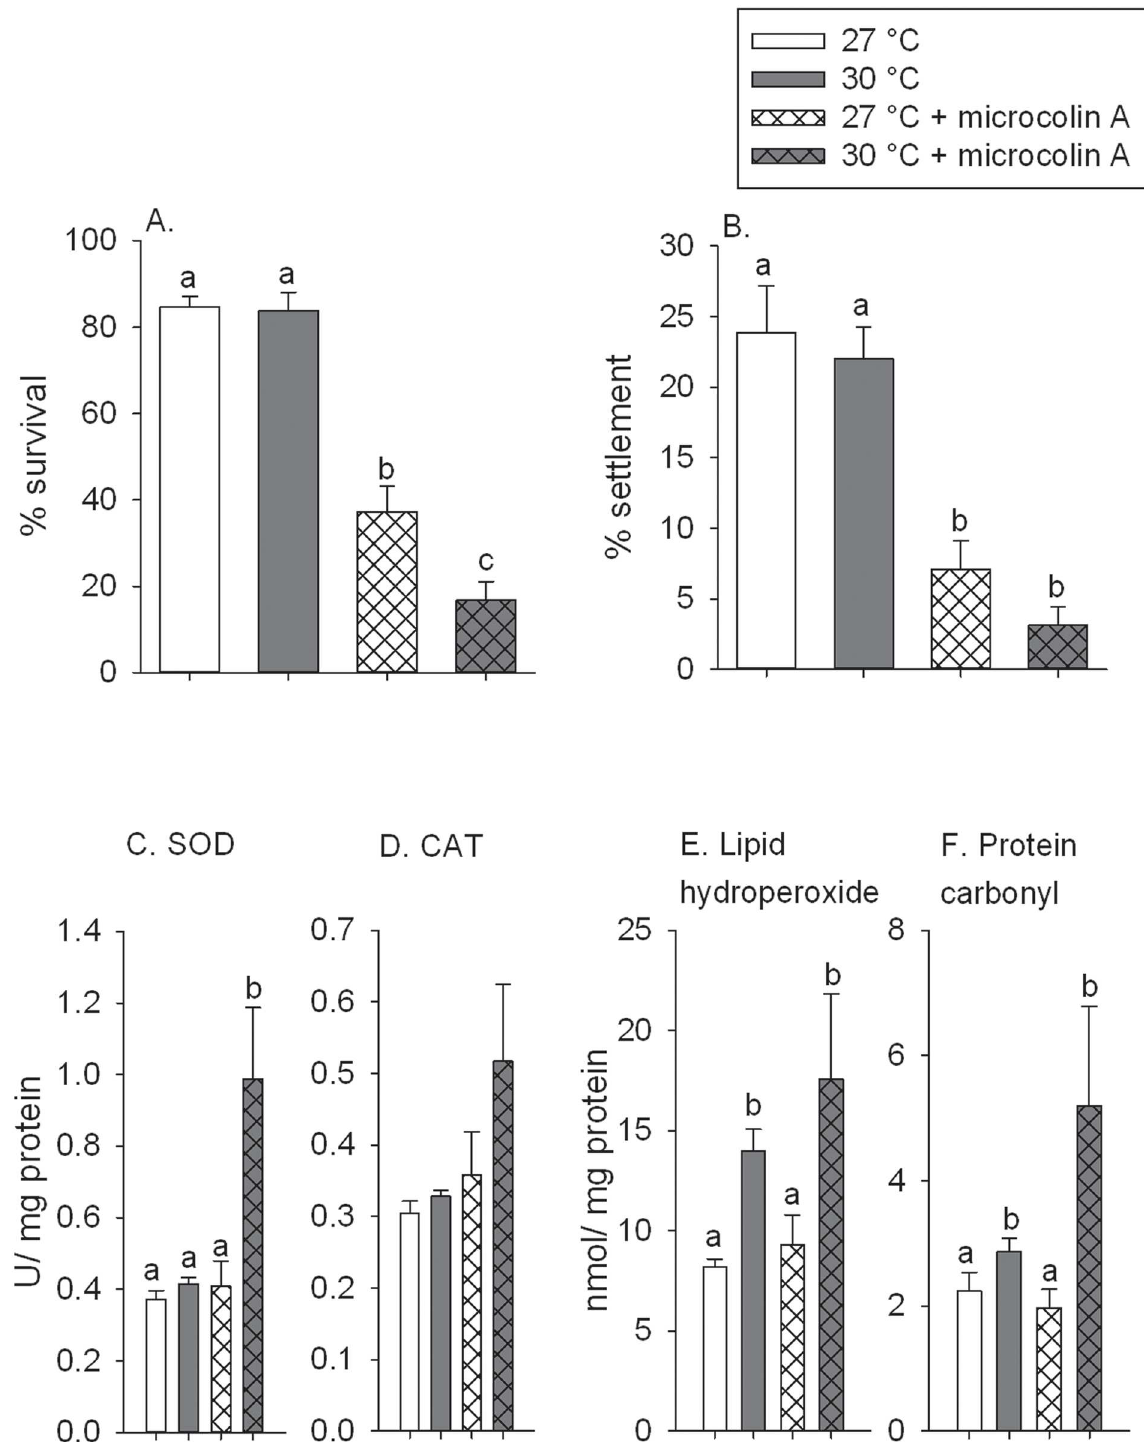
Fig 4. Experiment 2, larval exposure to elevatedseawatertemperature and microcolin A concurrently. Bars are untransformed means and error bars are +1 SE, shared letters above the bars indicate means that are not significantlydifferent. (A) The percent of larval survival and (B) the percent of larval settlement after a four days exposureto the treatments. (C) The activity of superoxidedismutase (SOD) and (D) catalase(CAT) after four days of exposure. (E) Lipid hydroperoxideand (F) protein carbonylationcontent followingfour days of exposureto the